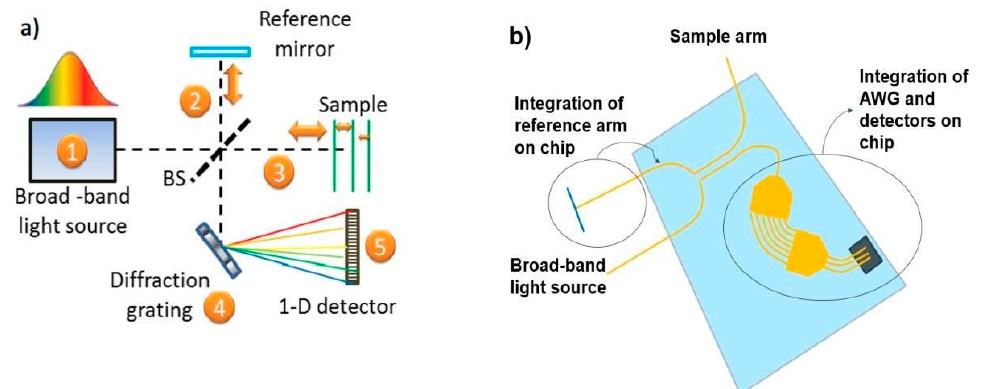
Figure 2. Schematic of a spectral-domain OCT system ( a ) as of today including broad-band light source, beam-splitter, reference- and sample-arm, diffraction grating, and detector. In our work ( b ) the beam-splitter, reference arm, grating (AWG), and detectors are integrated on a PIC.